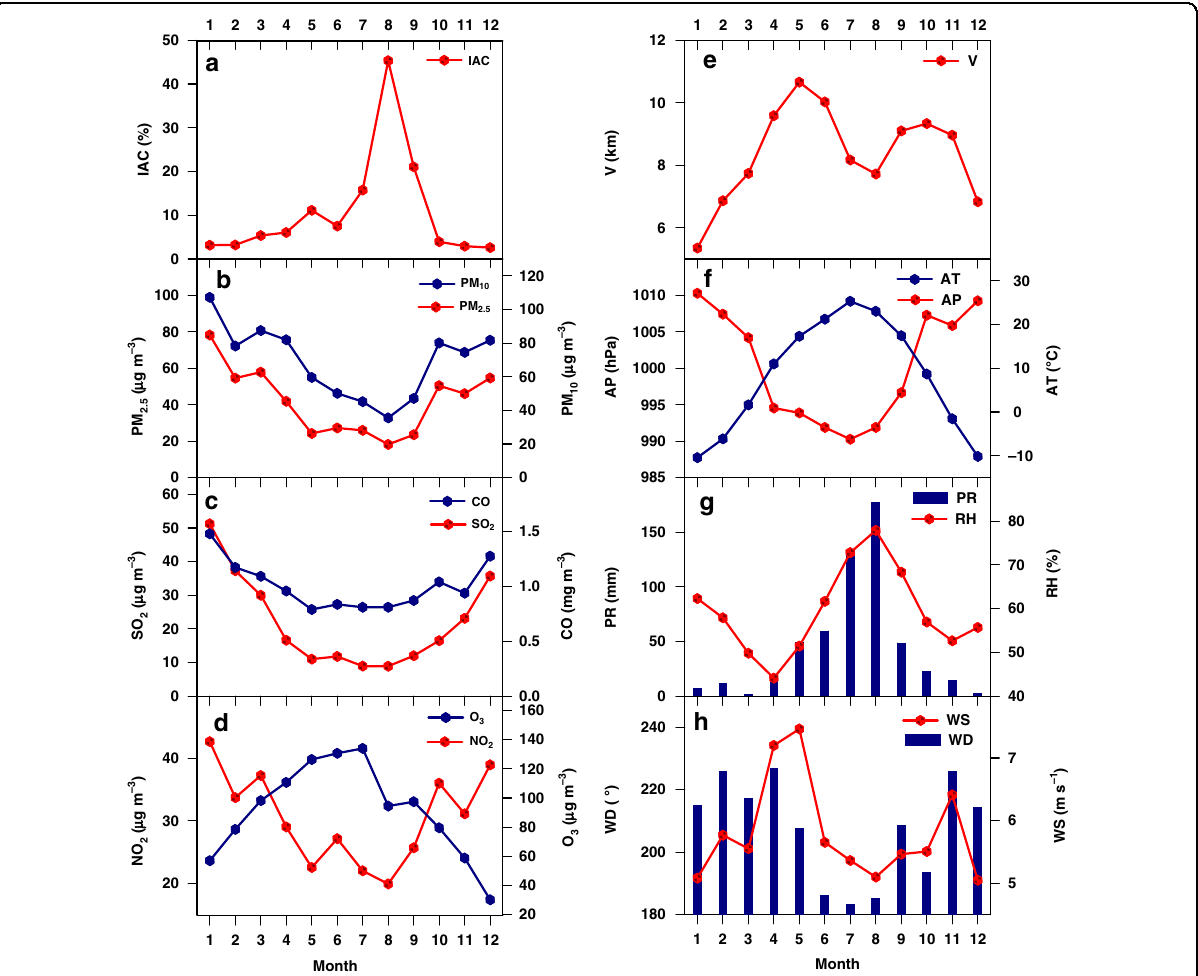
Fig. 2 Monthly variations of the IAC. a , concentrations of atmospheric pollutants b – d , and meteorological factors e – h . The data of three types in each month were averaged by valid data at prefecture-level cities in 2017. IAC incidence of allergic conjunctivitis, AP Air pressure, AT Air temperature, RH Relative humidity, V Visibility, PR Precipitation, WS Wind speed, WD Wind